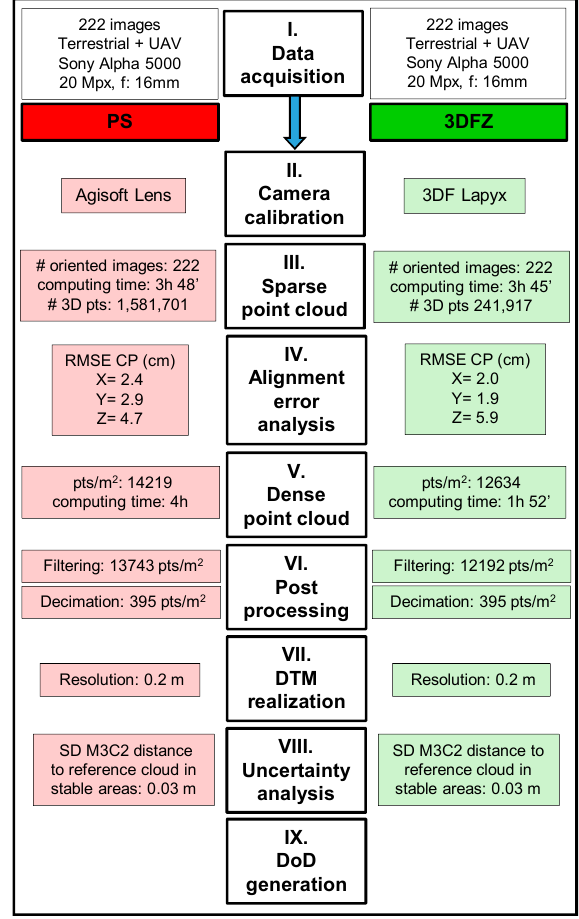
Figure 1. Workflow applied for image processing and point cloud post-processing, together with a comparison of the results obtained through 3DF Zephyr (3DFZ) and Photoscan